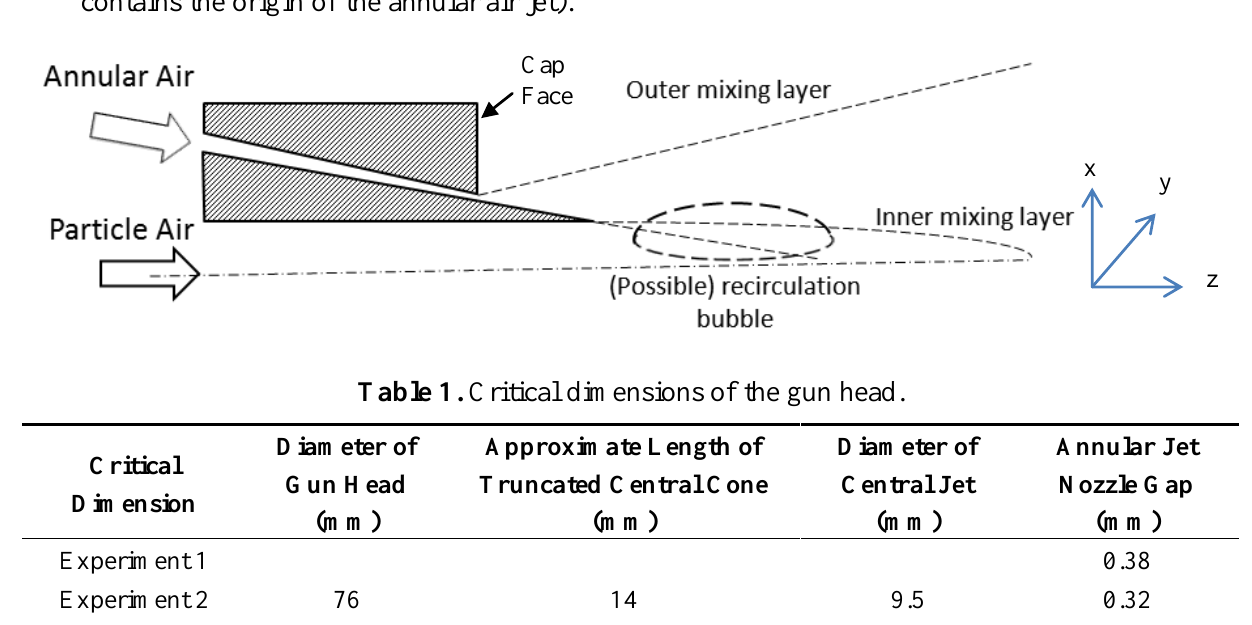
Figure 2. Schematic longitudinal section through a radius of the gun head. (The horizontal dashed line is the centerline of the jet. The plane z = 0 is located at the cap face. This plane contains the origin of the annular air jet).